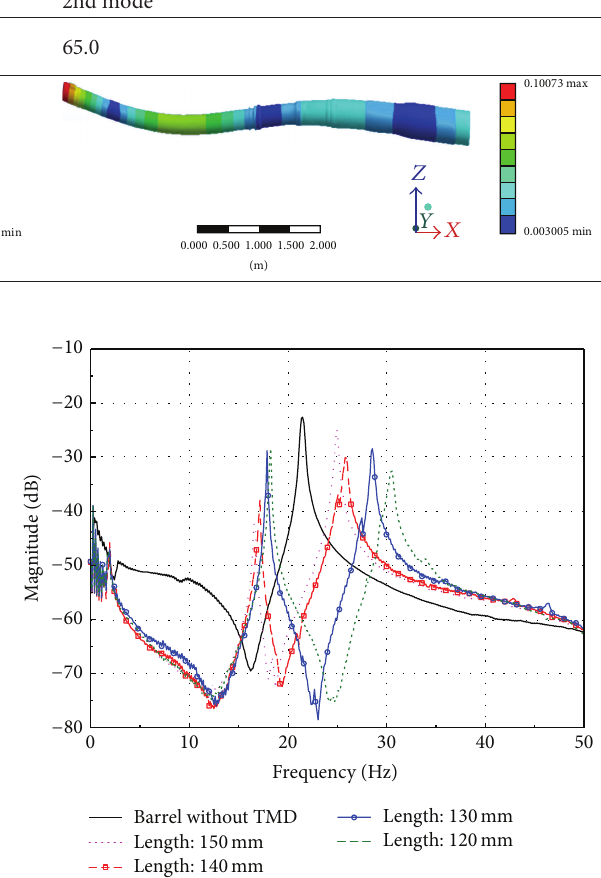
Figure 11: Frequency response functions of TMD.